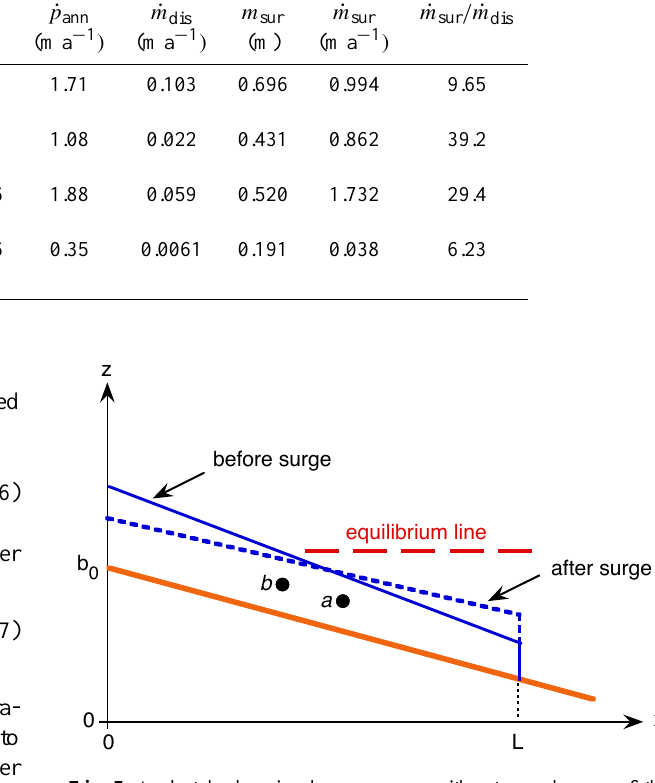
Fig. 5. A sketch showing how a surge without an advance of the glacier front can be represented in the simple geometry used earlier, by adjusting the surface slope (compare with Fig. 1).